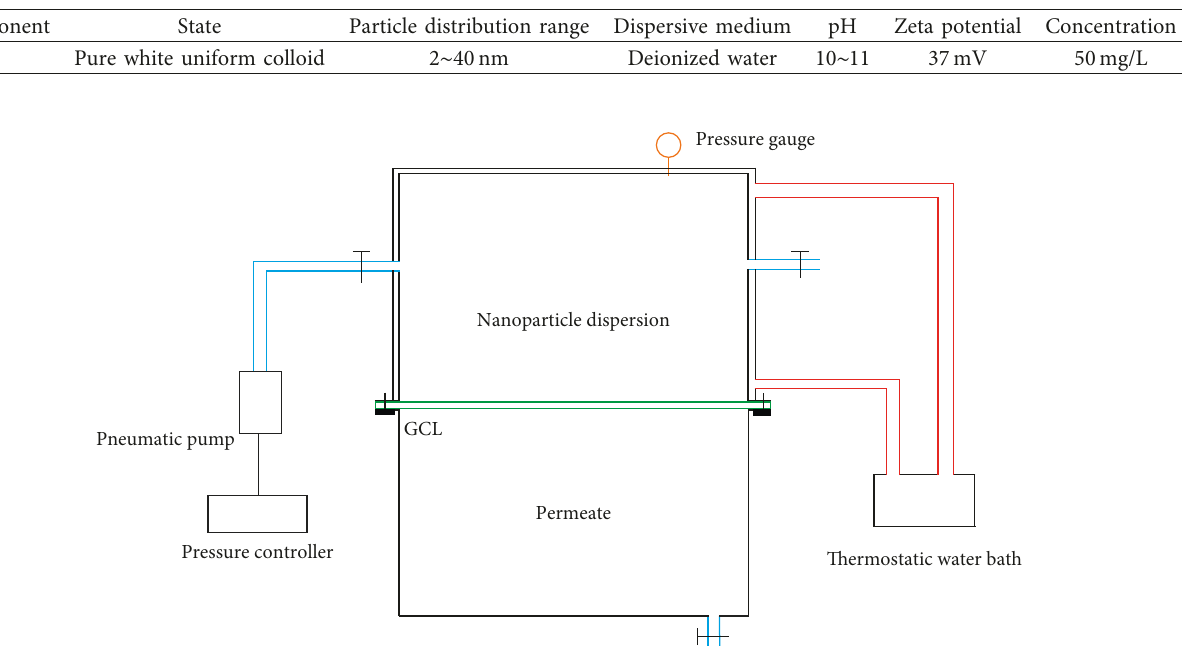
Figure 1: Structural representation of the GCL. Table 3: The basic properties of nZnO suspensions.